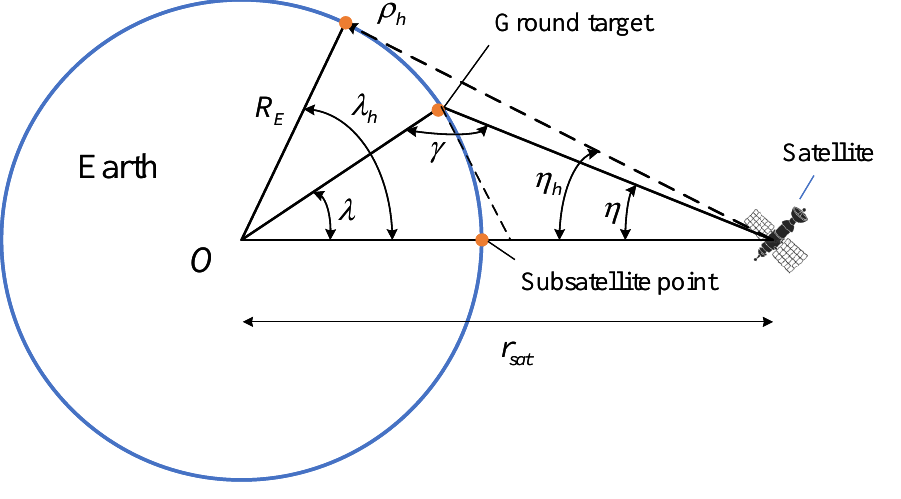
Figure 1. Satellite coverage on the